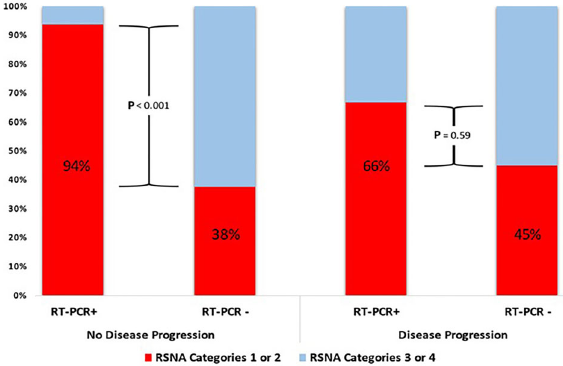
Figure 2. Radiological Society of North America (RSNA) categories according to RT-PCR results and disease progression (Fisher ’ s exact